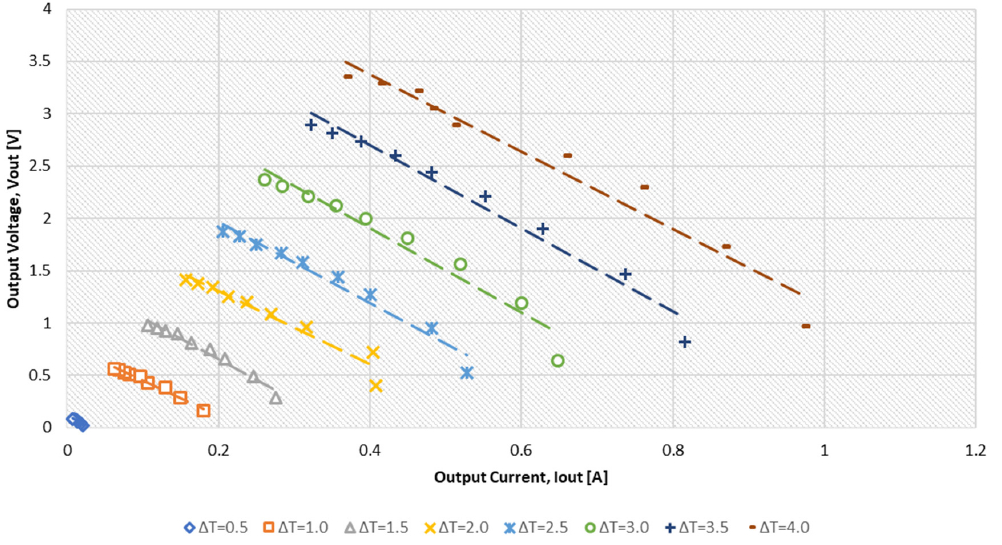
Figure 8. Thermal EHC Output Voltage–Output Current curve at 3.3 V.